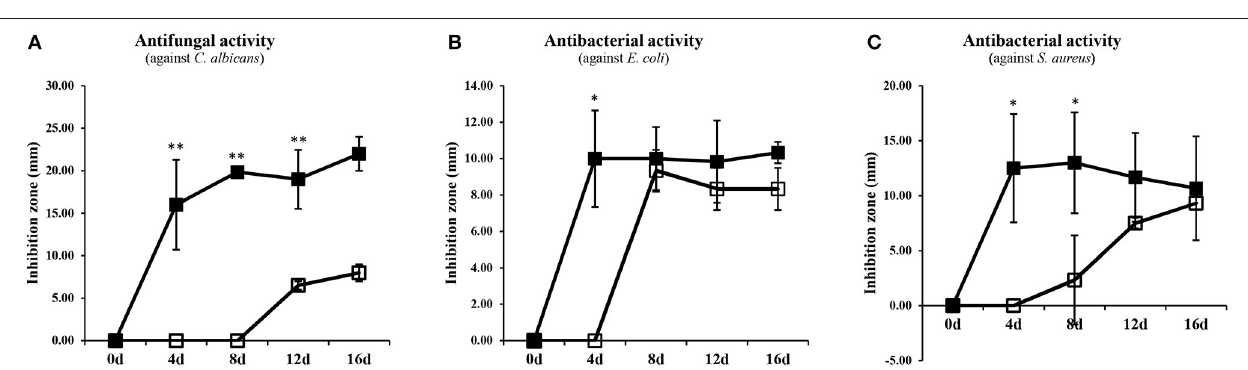
FIGURE 4 | Antimicrobial activity from SSF and SmF extracts (1 mg/100 µ L) against (A) Candida albicans , (B) Escherichia coli , and (C) Staphylococcus aureus . The size of disk was 6mm. Data are shown as means ± S.D ( n = 3). Significant differences between the SSF and SmF groups were identified by t -test (* p < 0.05, ** p < 0.01). (cid:4) , Solid-state fermentation; (cid:3) , Submerged